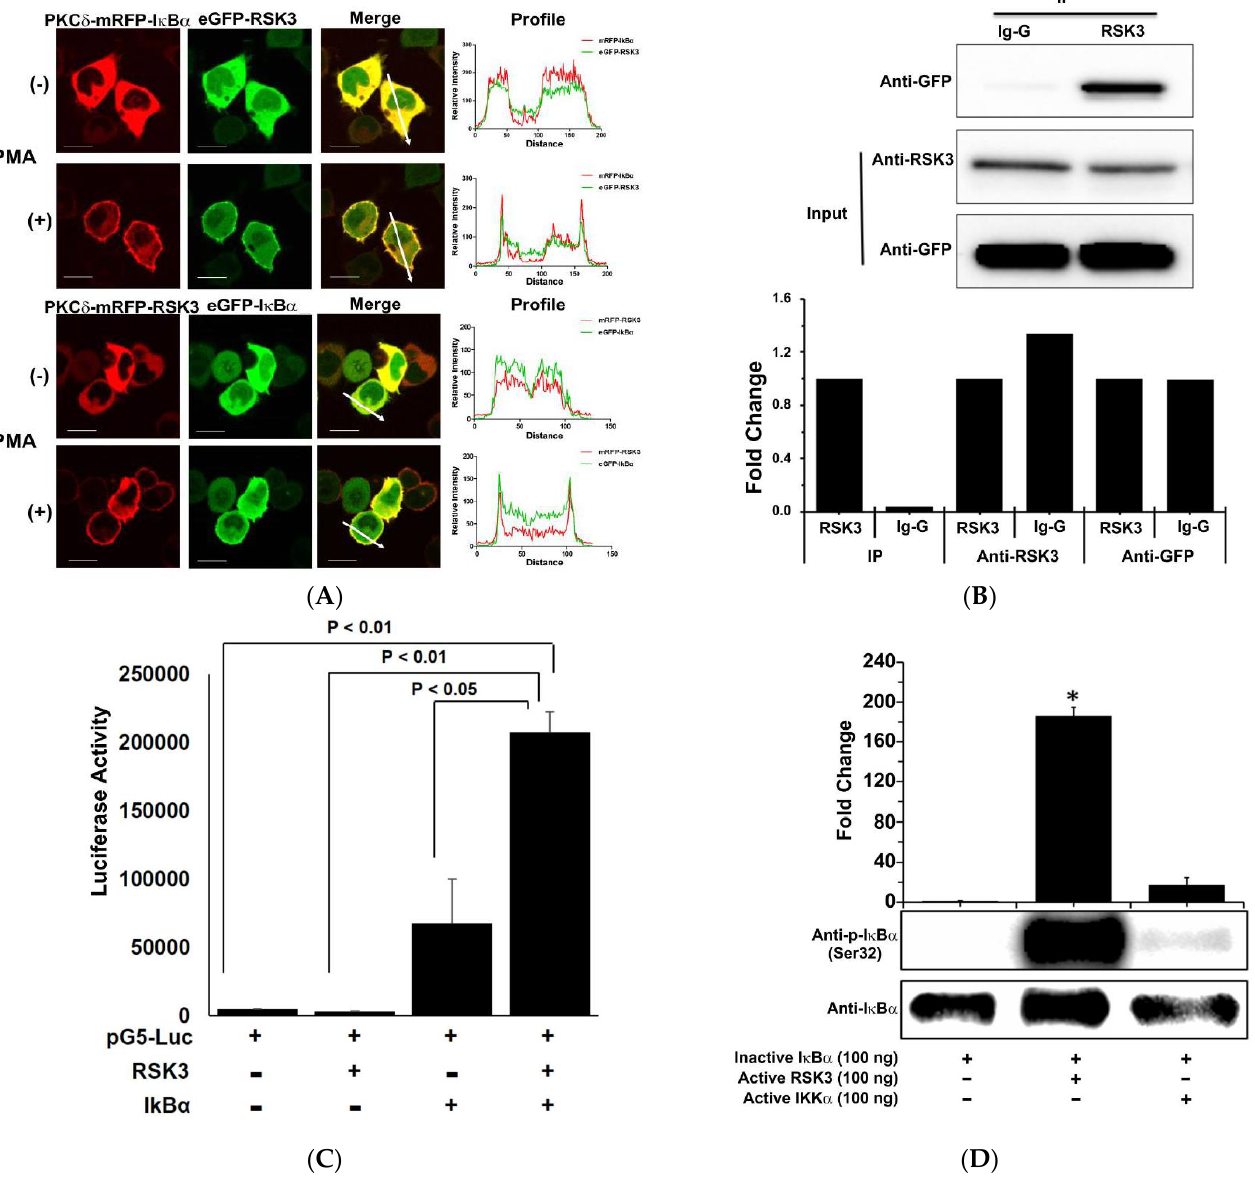
Figure 2: Figure 1. RSK3 interacts with I κ B α and regulates its phosphorylation. ( A ) Two pairs of vectors, pKC δ -mRFP-I κ B α /pAC- GFP-RSK3 or pKC δ -mRFP-RSK3/pAC-GFP-I κ B α , were co-transfected into HEK293T cells, and CUPID analysis